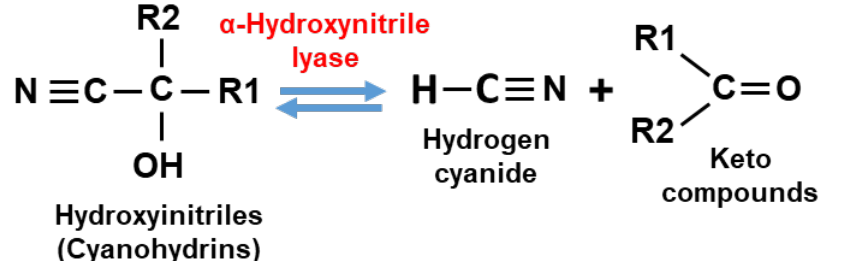
Figure 1. Enzymatic reaction for cyanohydrin and HCN interconversion catalysed by α -hydroxynitrile lyase.